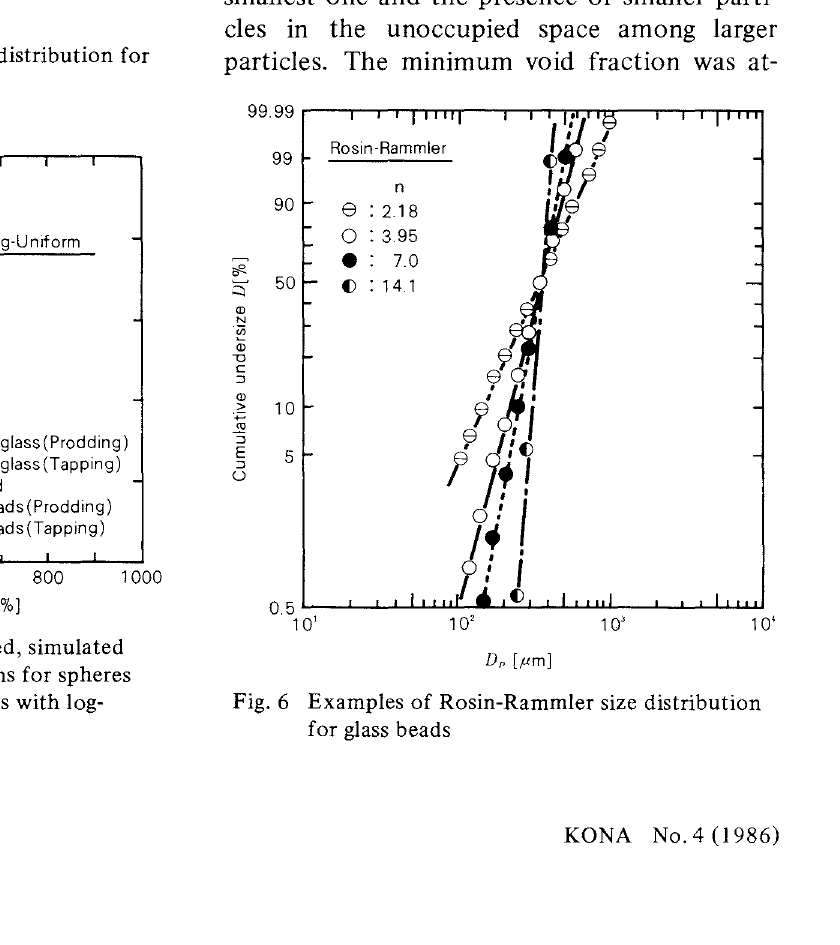
Fig. 4 Examples of log-uniform size distribution for crushed glass